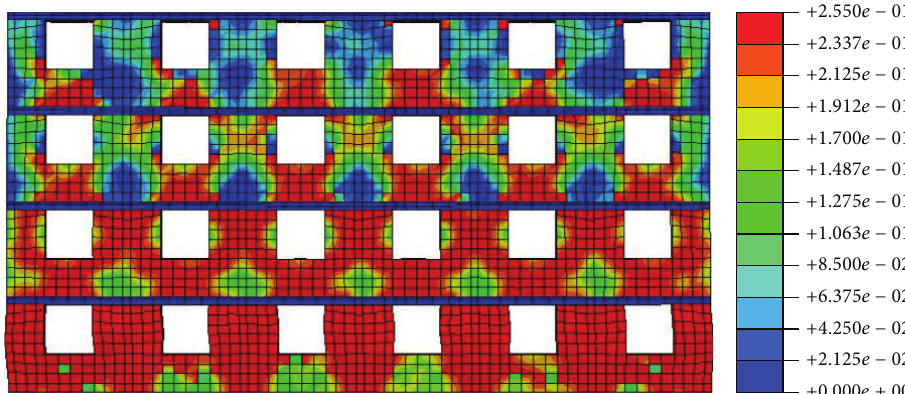
Figure 22: Tension crack damage cloud of model 4 under Wolong ground